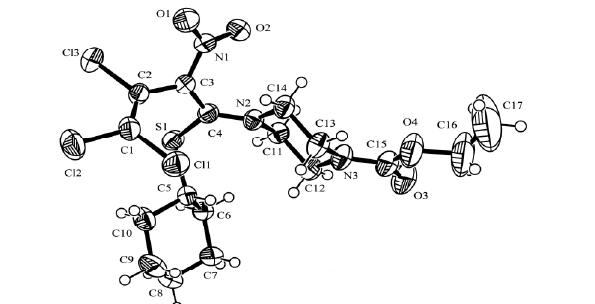
Figure 2. ORTEP view of the molecular structure of 4g in the crystal; displacement ellipsoids are drawn at the 50% probability